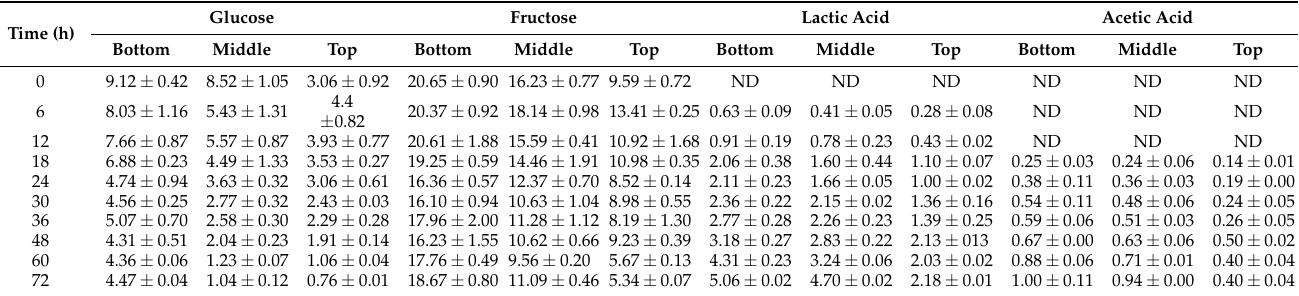
Table 2. Sugar consumption and organic acids production (g l − 1 ) during spontaneous